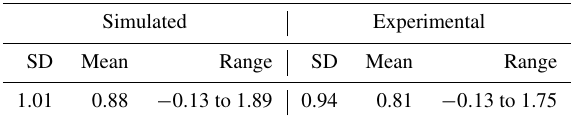
Table 10. Humidity – Simulated verses experimental statistics.